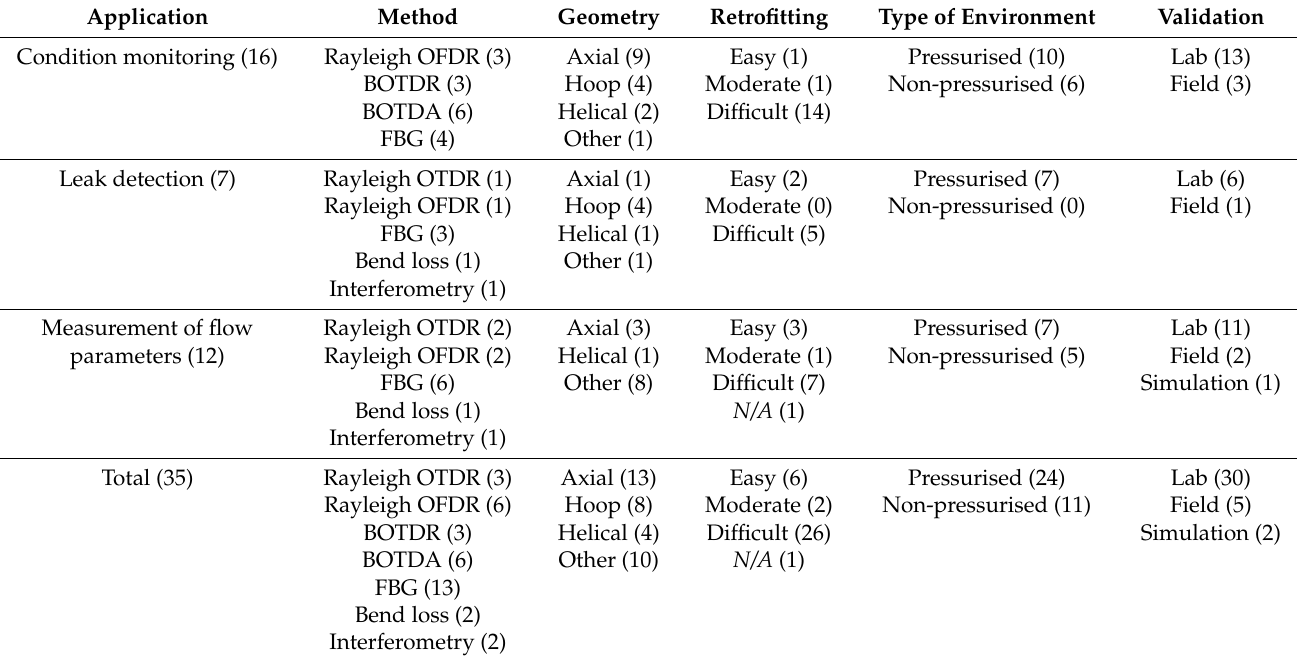
Table 1. A selective summary of information presented in papers reviewed in Section 3. The figures in the brackets correspond to the numbers of related